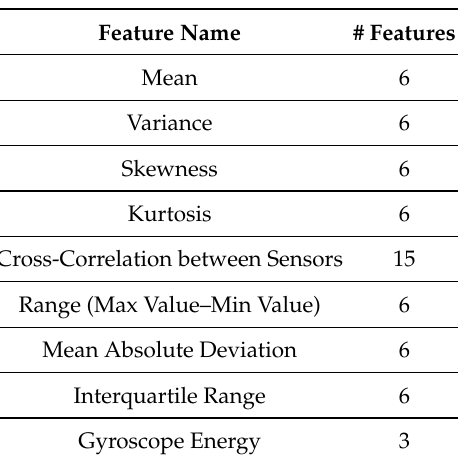
Table 1. Feature